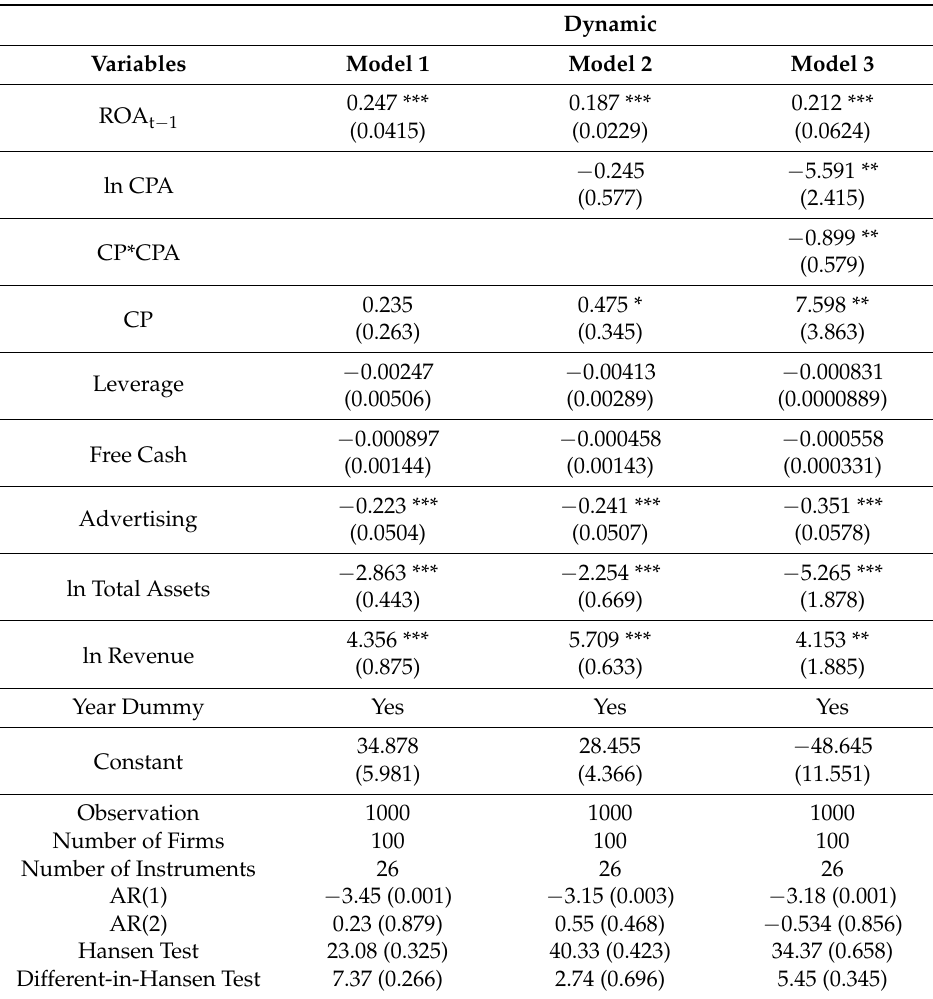
Table 4. The Moderating Effect of CP on CPA and Firm Performance